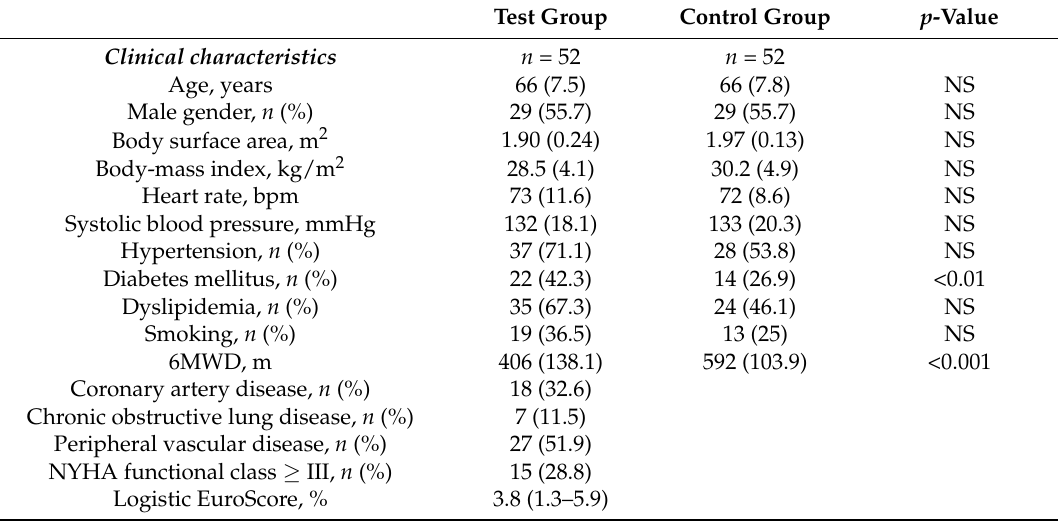
Table 1. Baseline characteristics of patients in the test and control